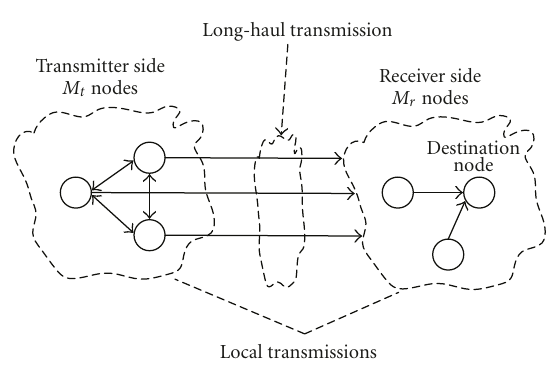
Figure 1: MIMO-based approach for